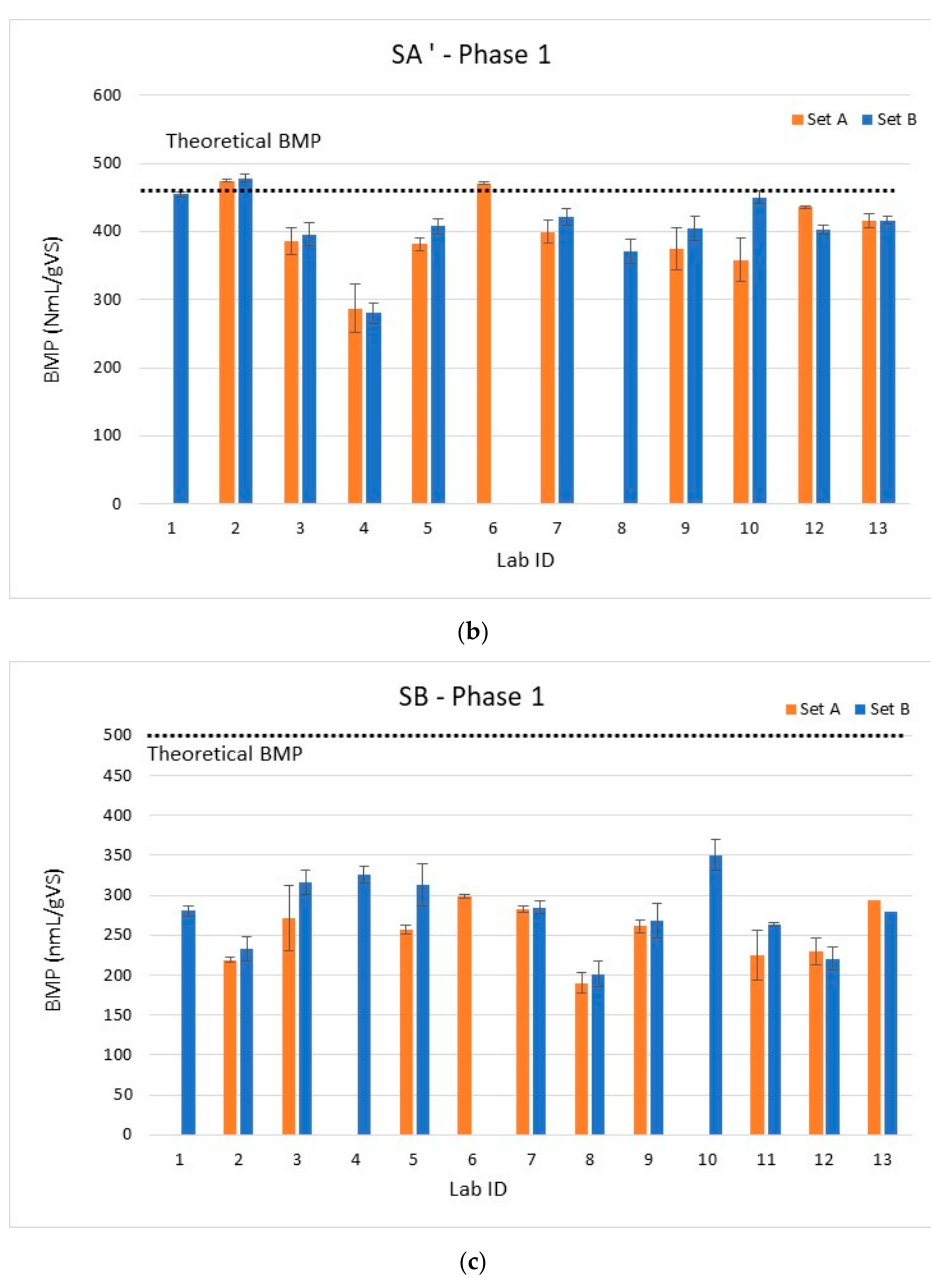
Figure 4. Summary of BMP values measured for the results of the first phase—free protocols showing intra-laboratory repeatability and intra-laboratory reproducibility: ( a ) SA; ( b ) SA’; ( c ) SB.